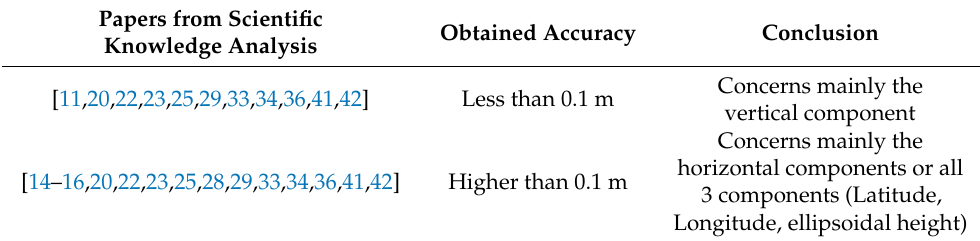
Table 1. The summary of research works from scientific knowledge analysis. Papers from